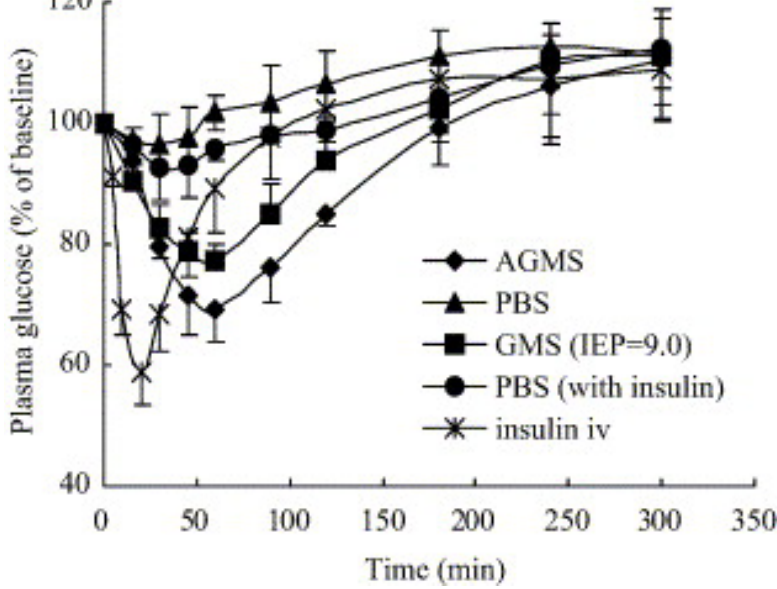
Figure 3. Comparative hypoglycemic effects of EE–NPs (crosslinked with epichlorohydin/prepared emulsion method nanoparticles) in the presence of Na glycocholate and lysophosphatidylcholine after nasal administration to